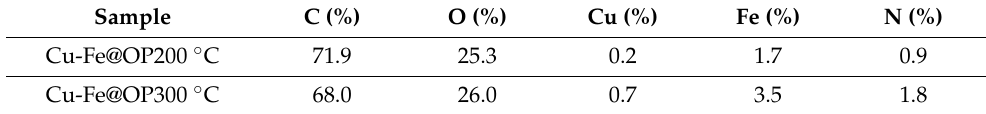
Table 2. Chemical compositions obtained by X-ray photoelectron spectra (XPS)